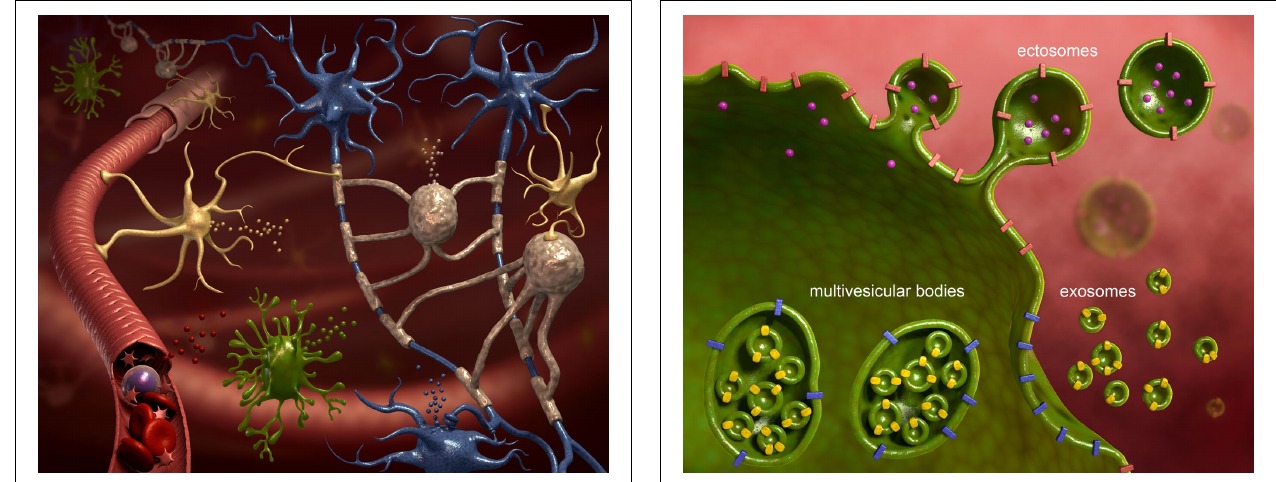
FIGURE 2 | Microvesicles are of different subcellular origin. MVs released from various neural cell types have different subcellular origin. In the present review we consider ectosomes, also called shed vesicles, and exosomes. Ectosomes shed from the plasma membrane carrying along transmembrane proteins, and soluble proteins, nucleic acids, and metabolites present in the cytoplasm. Ectosomes are large and heterogeneous in size. Exosomes derive from the release of multivesicular bodies, an intracellular organel along the endocytic pathway, that controls membrane composition and content. Exosomes are small and homogenous in